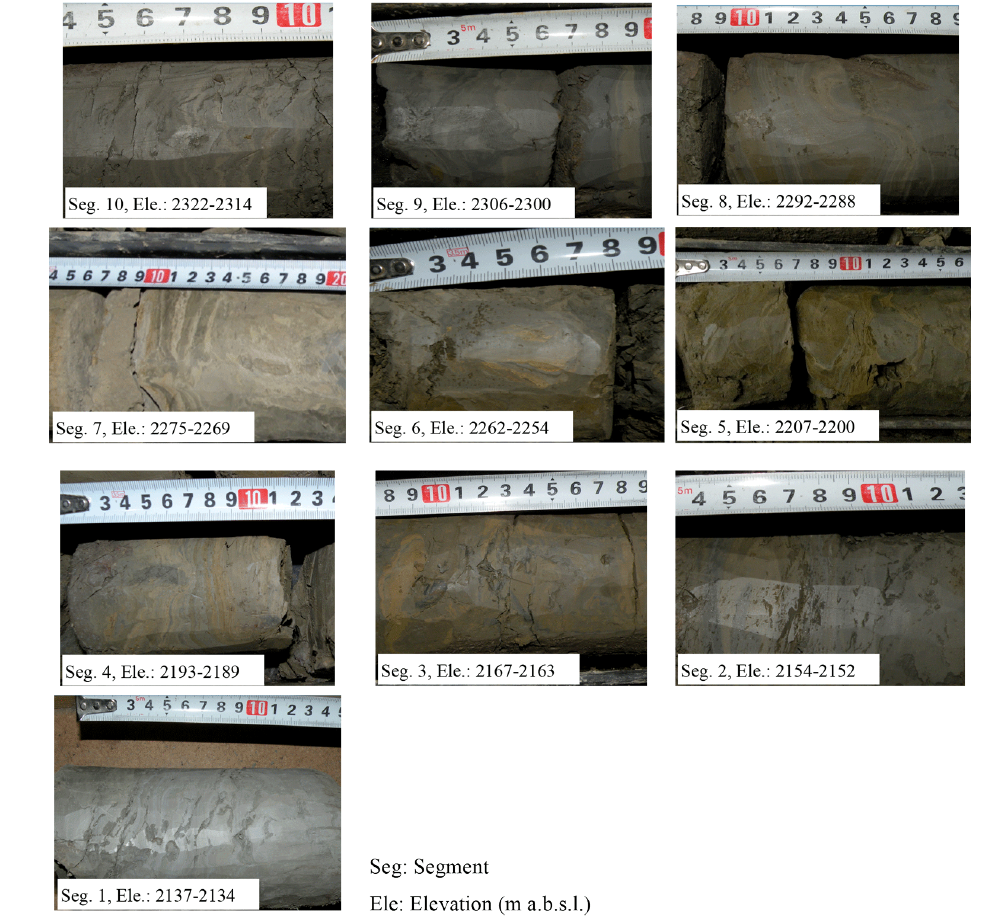
Figure 10. Features of disturbance layers in the drilling